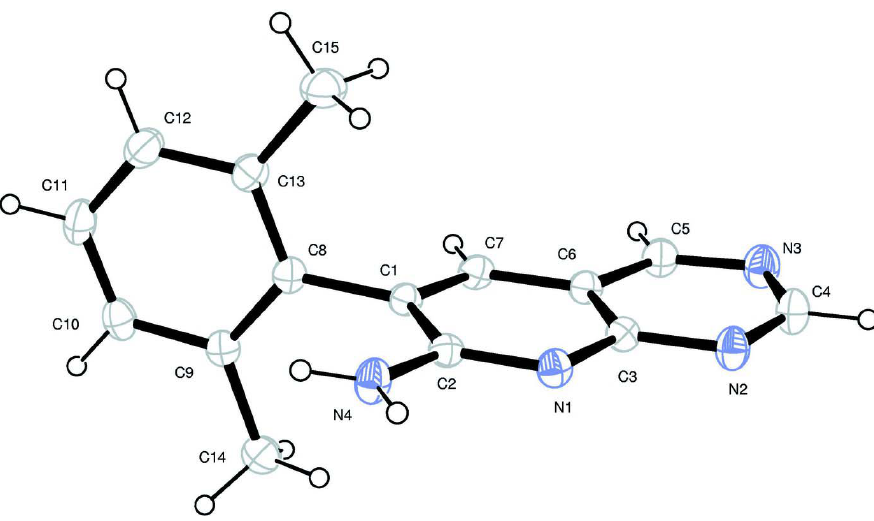
Figure 1 Molecular structure of the title compound, showing 50% probability displacement ellipsoids and atom numbering scheme. H atoms are drawn as circles with arbitrary small